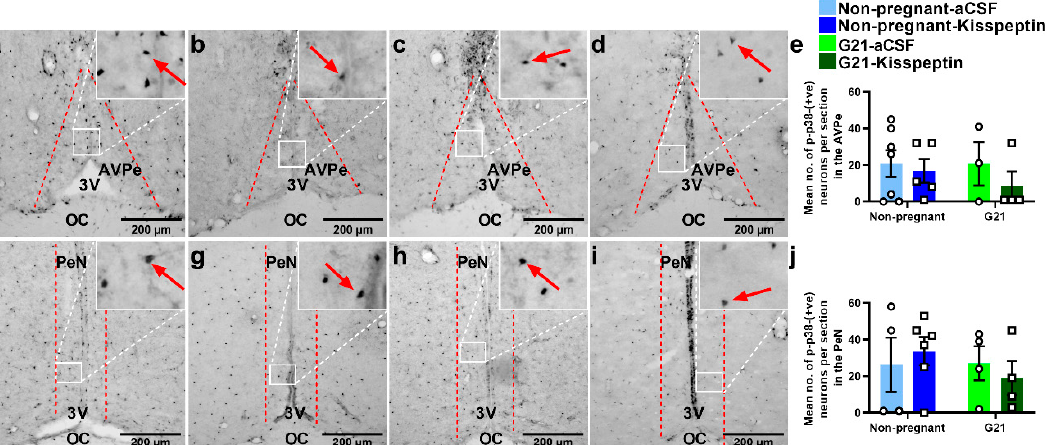
Figure 10. Kisspeptin does not affect p-p38 expression in AVPe or PeN neurons of non-pregnant and G21 rats. Photomicrographs of coronal sections containing the AVPe ( a – d ) and PeN ( f – i ), within the red dotted area, showing p-p38-positive neurons in non-pregnant rats ( a , b , f , g ) and G21 rats ( c , d , h , i ) after ICV administration of aCSF ( a , c , f , h ) or kisspeptin (2 µg in 2 µL; b , d , g , i ). Red arrows point to representative p-p38 labelling. Mean (± SEM) number p-p38-positive neurons per section in the ( e ) AVPe (RS: F (1,1) = 0.231, p = 0.637; T: F (1,1) = 0.882, p = 0.362; RS × T: F (1,2) = 0.225, p = 0.641, two-way ANOVA) of non-pregnant (aCSF-treated, n = 7, kisspeptin-treated, n = 5) and G21 rats (aCSF-treated, n = 3, kisspeptin-treated, n = 4), and ( j ) PeN (RS: F (1,1) = 0.455, p = 0.510; T: F (1,1) = 0.0008, p = 0.977; RS × T: F (1,2) = 0.559, p = 0.467, two-way ANOVA) of non-pregnant (aCSF-treated, n = 4, kisspeptin-treated, n = 6) and G21 rats (aCSF-treated, n = 4, kisspeptin-treated, n = 4). AVPe anteroventral periventricular nucleus, OC optic chiasma, PeN periventricular nucleus, 3V third ventricle, scale bar = 200 µm.